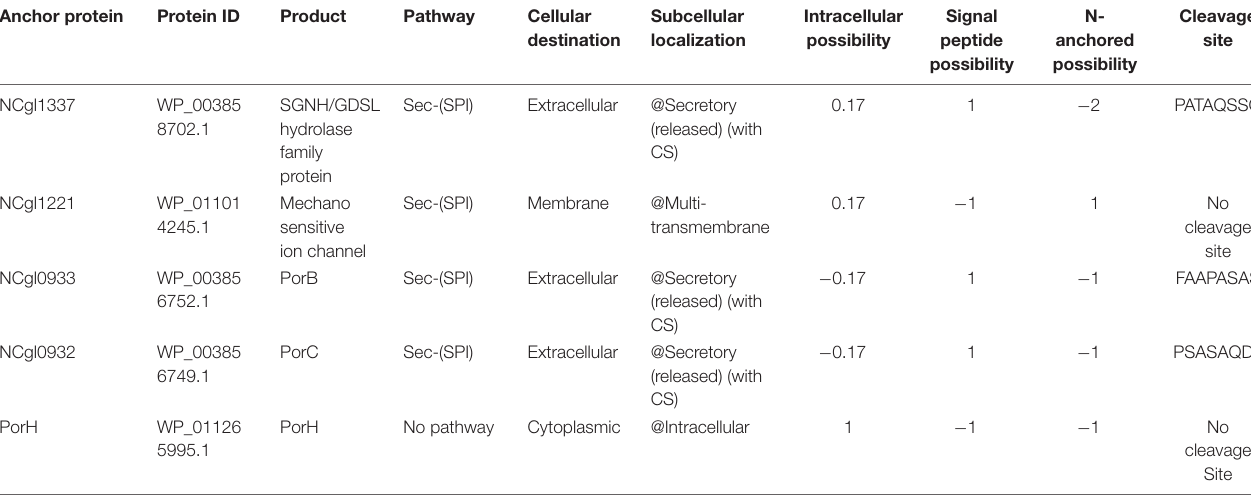
TABLE 1 | The prediction results of the known endogenous anchor proteins of C. glutamicum made by LocateP: (1) Intracellular probability score: range − 1 to + 1, threshold: 0.5. Anchor protein